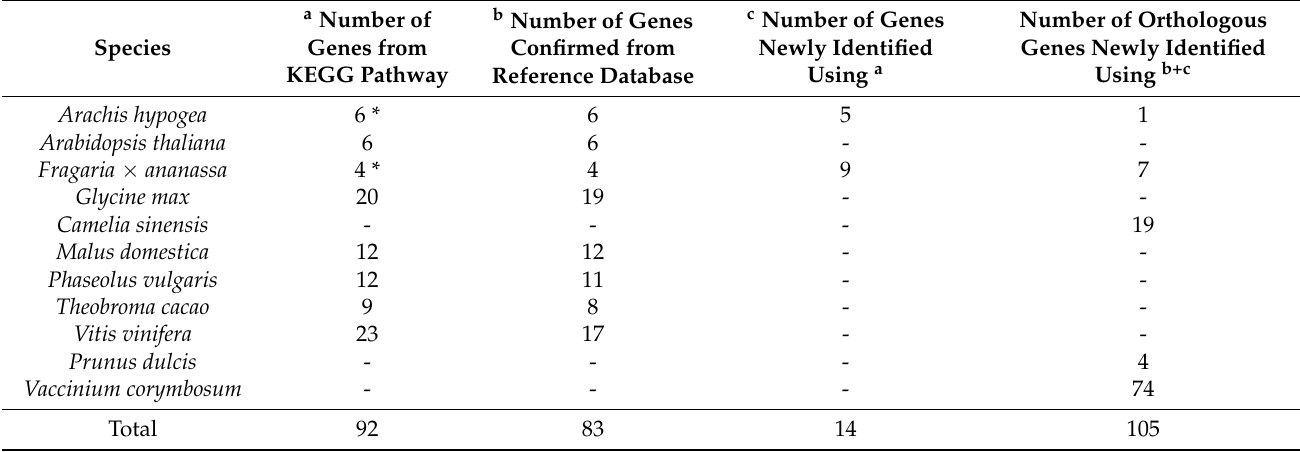
Table 2. Numbers of genes involved in proanthocyanidins production in the 11 species. Based on sequence similarity, orthologous genes were searched using BLASTP.